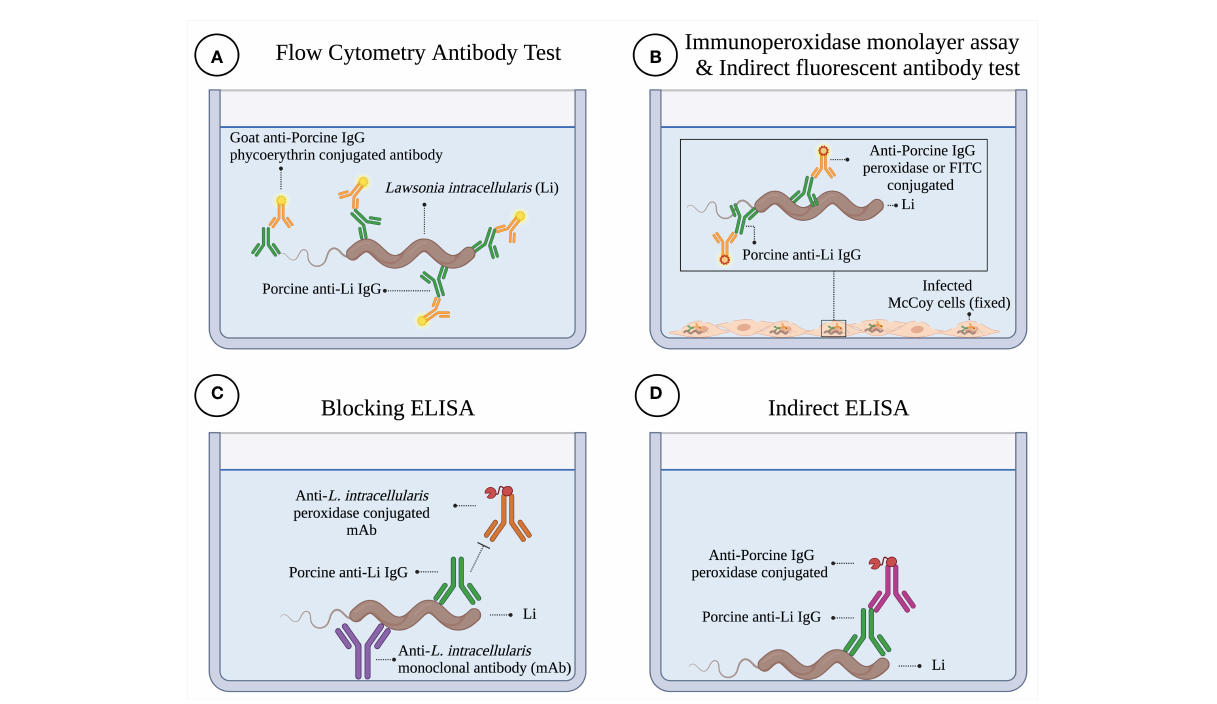
FIGURE 8 Illustration of different serological diagnostic tests for Lawsonia intracellularis . (A) Flow Cytometry Antibody Test. In this assay, porcine antibodies interact with L. intracellularis fl oating in the well of the plate. The binding of speci fi c antibodies to L. intracellularis is demonstrated with a phycoerythrin-conjugated antibody speci fi c for porcine IgG. The test is read on the fl ow cytometer. (B) Immunoperoxidase Monolayer Assay (IPMA) & Indirect Fluorescent Antibody Test (IFAT). In these assays, cells (i.e., McCoy cells) infected with L. intracellularis are chemically fi xed with acetone- methanol, which promotes a structural change in the cell (cytoplasmic membrane damage, as indicated in fi gure). This damage is essential for porcine antibodies to interact with L. intracellularis . The presence of antibodies bound to L. intracellularis is demonstrated by a peroxidase conjugate antibody plus chromogen (3-amino-9-ethyl-carbazole) solution (IPMA). In the case of IFAT, a fl uorescein isothiocyanate conjugated antibody is used to reveal the presence of porcine IgG bound to the pathogen. Plates are read under an inverted microscope. (C) Blocking ELISA. In this ELISA, a monoclonal antibody bound to the ELISA plate is used to capture L. intracellularis . Porcine antibodies compete with the peroxidase-conjugated monoclonal antibody for a speci fi c epitope present on a surface antigen of L. intracellularis . The presence of porcine antibodies to L. intracellularis is determined by the potential to reduce or inhibit binding of the monoclonal antibody and, therefore, the enzymatic reaction associated with the competing conjugated antibody. (D) ELISA Indirect. In this ELISA, L. intracellularis is immobilized directly on the ELISA plate; and for this reason, a considerable surface area of the antigen is not accessible to antibodies (physical masking of antigens). Porcine antibodies that recognize L. intracellularis are detected with a peroxidase-conjugated anti-porcine IgG antibody. This fi gure was created with